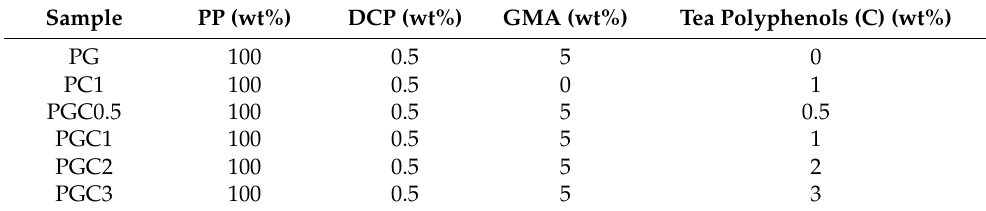
Table 1. PP/DCP/GMA/C blends with different composite